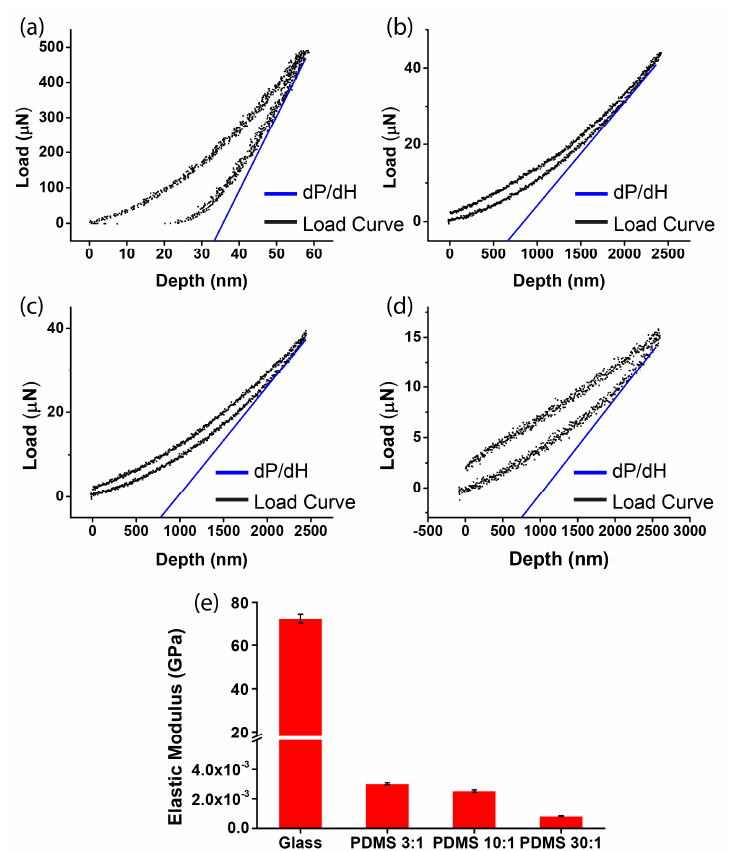
Figure 2. Measurement of substrate stiffness by nano-indentation. The load–depth curve of the micropatterned substrates of ( a ) glass (d P was 490.7 μ N and d H was 58.7 nm); ( b ) PDMS, ratio of elastomer to cross-linker = 3:1 (d P was 43.9 μ N and d H was 2420.3 nm); ( c ) PDMS, ratio of elastomer to cross-linker = 10:1 (d P was 38.7 μ N and d H was 2447.8 nm); and ( d ) PDMS, ratio of elastomer to cross-linker = 30:1 (d P was 15.2 μ N and d H was 2599.8 nm); ( e ) the elastic modulus of the four substrates after repeated experiments (mean ± SD; n = 3).